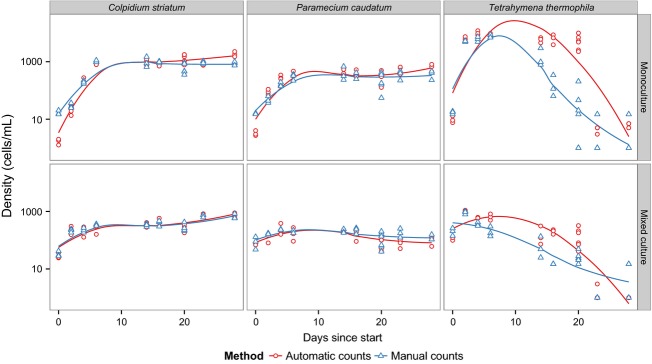
Population dynamics of three species of ciliates given by manual and automatic counting (fitted lines are local polynomial regressions) to illustrate the general growth dynamics. The mixed culture contains a combination of the three species used in the monocultures (Colpidium striatum, Paramecium caudatum, Tetrahymena thermophila).